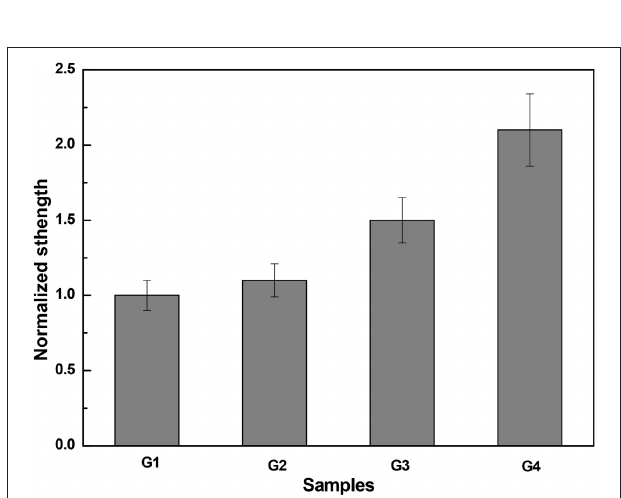
FIGURE 8 | Influence of different self-healing agent on flexural strength restoration of specimens.